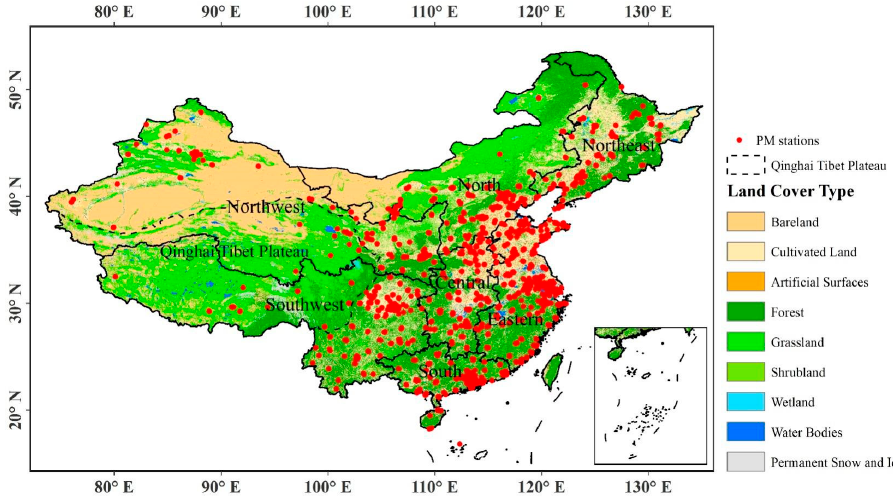
Figure 1. Study area land cover type and PM stations. Table 2. The main technical parameters of FY-4A